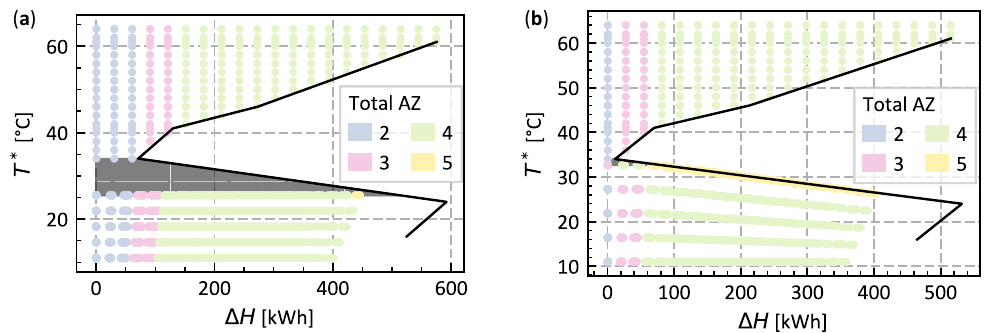
Figure 7. Adapted GCC with resulting number of AZs in the overall system depending on HP placement (AZ-information): ( a ) for 80 kWh initial solution and ( b ) for 140 kWh initial